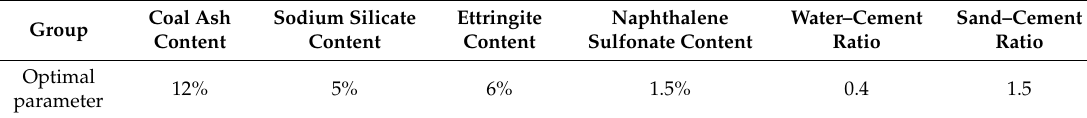
Table 10. Optimal combination of orthogonal test factors and levels.